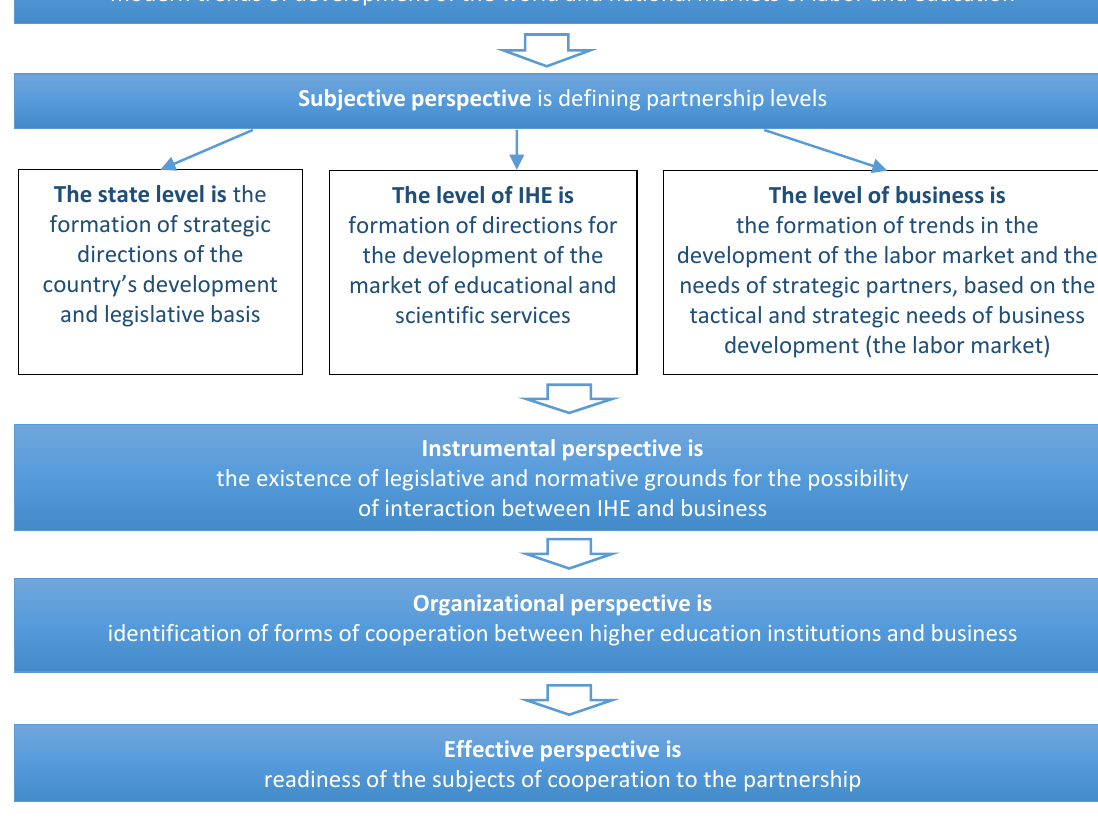
Figure 3. Prospects for the formation of interaction between IHE and